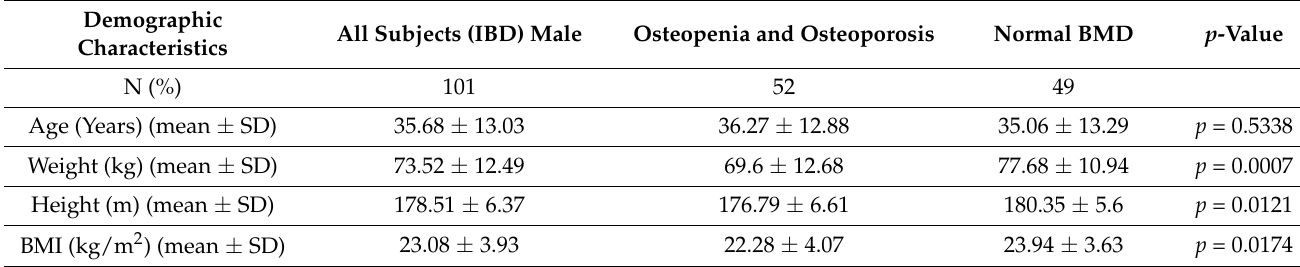
Table 5. The demographic and anthropometric parameters of the studied male IBD patients with respect to osteoporosis and osteopenia.